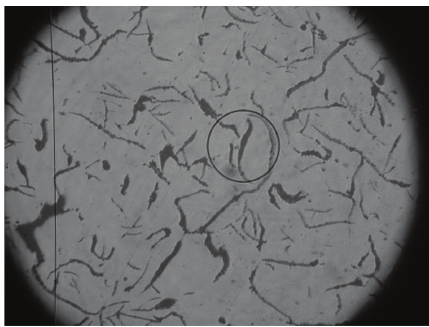
Figure 11: Microstructure in zone B 100x.